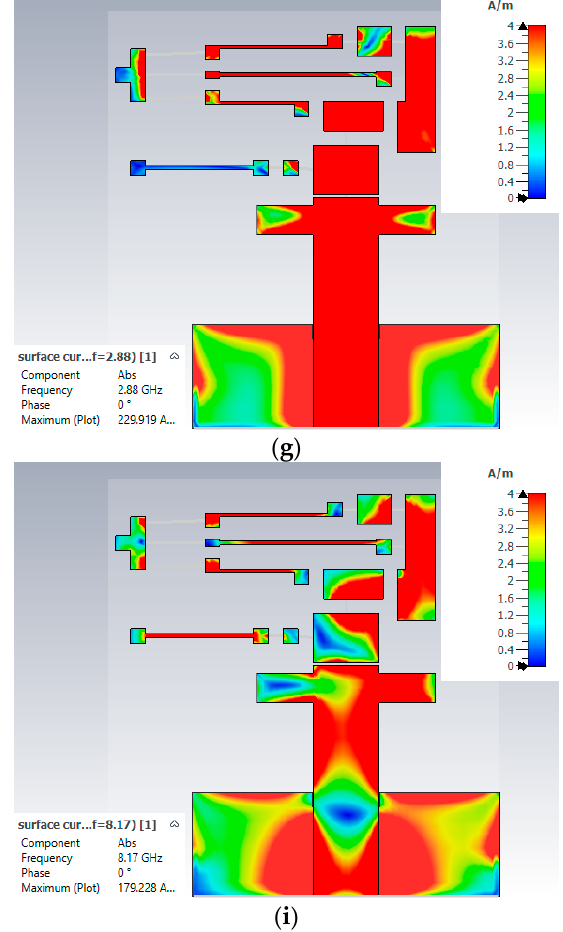
Figure 12. The surface current of the proposed antenna in various modes ( a ) 4.36 GHz (MODE 1), ( b ) 7.78 GHz (MODE 1), ( c ) 3.56 GHz (MODE 2), ( d ) 6.89 GHz (MODE 2), ( e ) 3 GHz (MODE 3), ( f ) 6.2 GHz (MODE 3), ( g ) 2.88 GHz (MODE 4), and ( h ) 5.87 GHz (MODE 4) and ( i ) 8.17 GHz (MODE 4). Table 3. Summary of antenna results.